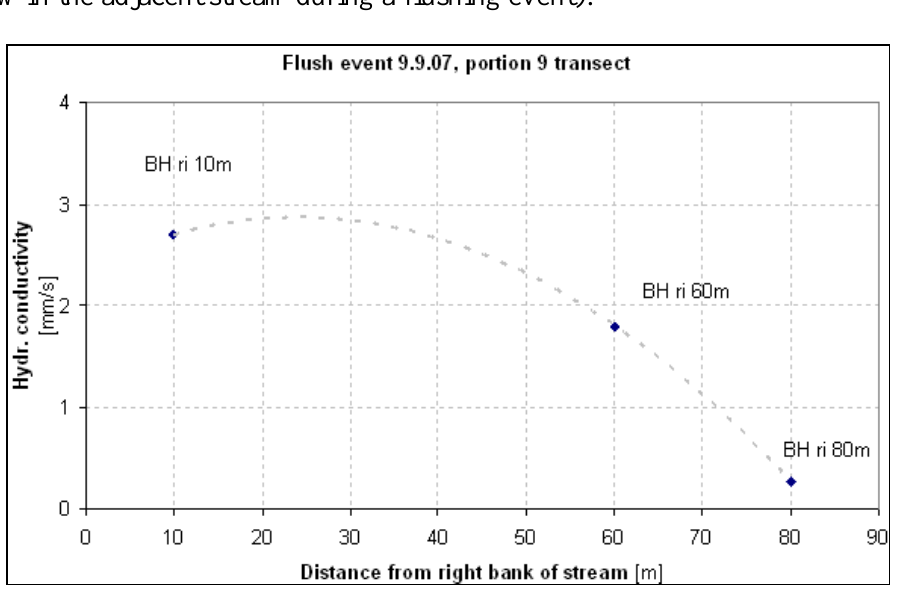
Figure 25. The lateral hydraulic conductivity of peat in relation to the distance from the stream (calculated based on lags of water level responses in the boreholes at portion 9 to peak flow in the adjacent stream during a flushing